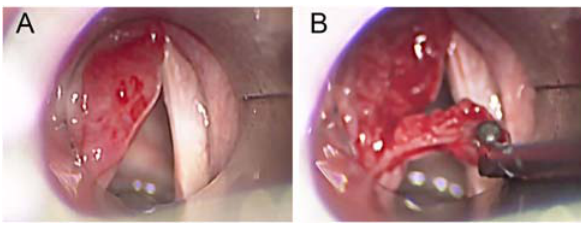
Figure 3: Intraoperative images: before ( A ) and during ( B ) the surgical